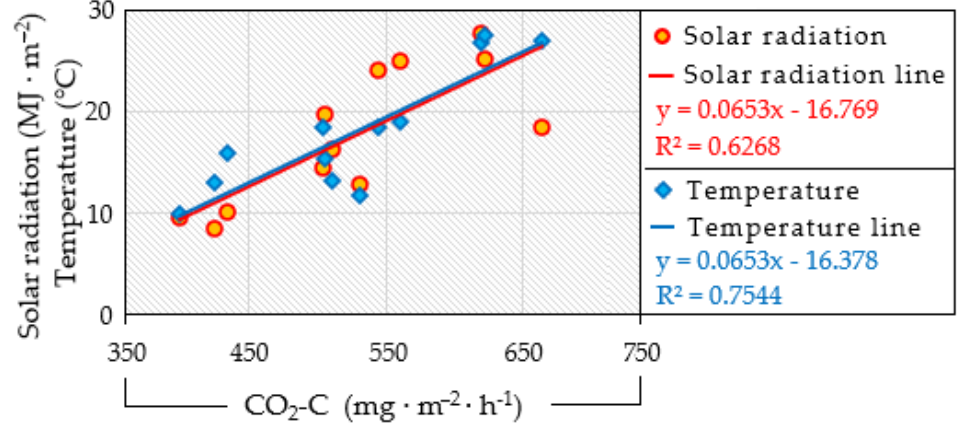
Figure 2. Linear regressions between the average monthly CO 2 emissions from the HF unit and the average air temperature values (blue line) and the average solar radiation values (red line) documented during the observation period (January – December 2021). Yellow circles and blue diamonds are solar radiation and temperature data, respectively.